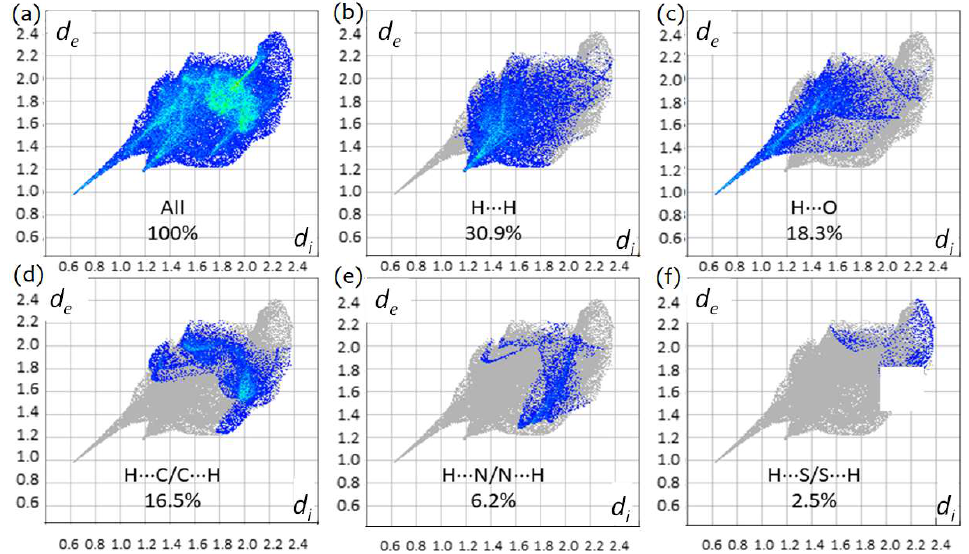
Figure 12. The two-dimensional fingerprint plots for TBZ-formic acid solvate crystal, showing ( a ) all interactions, ( b ) H···H, ( c ) H···O, ( d ) H···C/C···H, ( e ) H···N/N···H and ( f ) H···S/S···H interactions. Colored areas represent the contributions of atoms within specific interacting pairs, while the grey areas are a representation of the totality of interactions. Colors are determined by the fraction of surface points in 0.01 Å bin in both d e and d i . Actual colors span a continuous range, and are mapped using the HSV (Hue, Saturation, Value) scheme, where S ≈ V ≈ 1.0, and H ~ 0.66 (240°, blue) for minimum relative area, and H ≈ 0.0 (0°, red) for more than 0.1% of surface points in the bin. The largest contribution to the overall crystal packing in both compounds results from H . . .